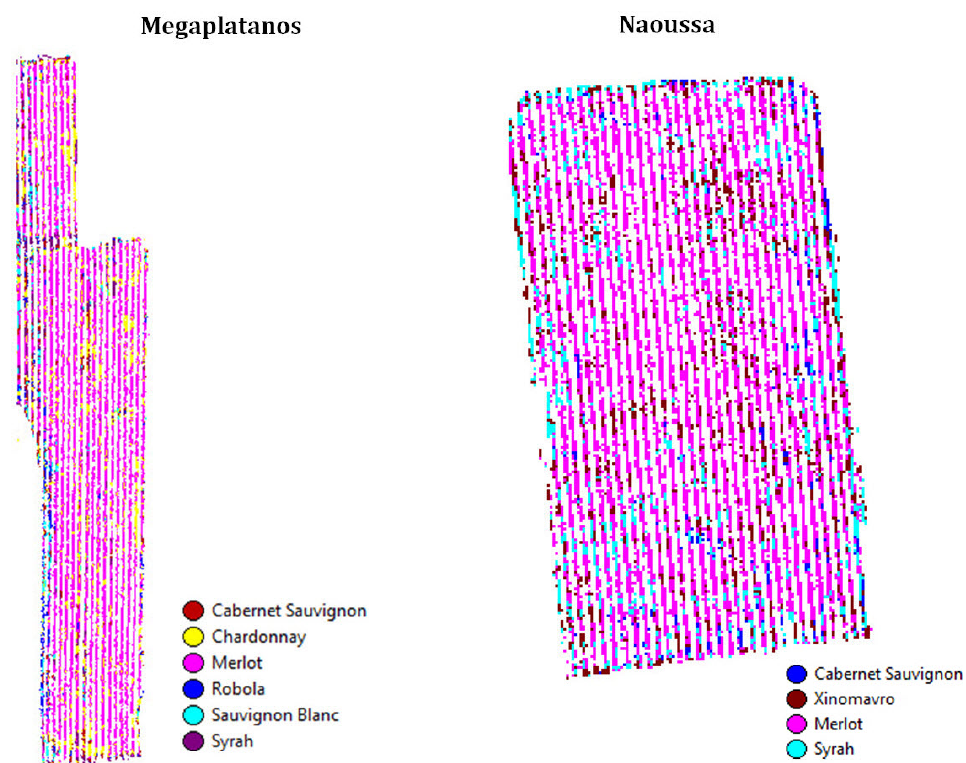
Figure 7. Typical examples of classification results based on the detected canopy (50-cm spatial resolution) over two Merlot vine